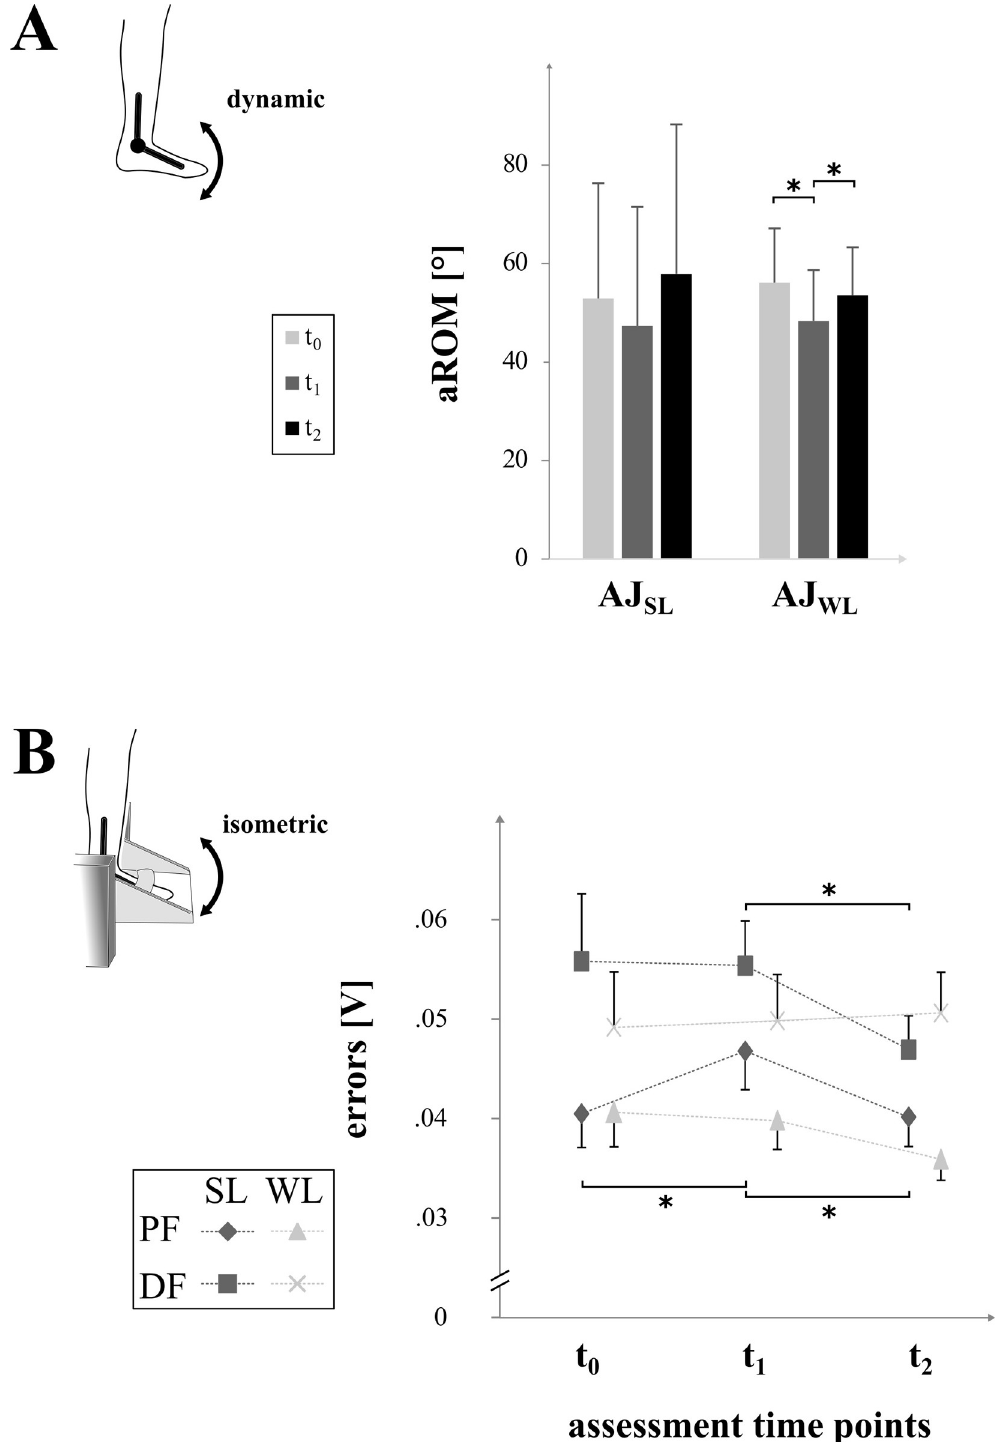
Fig 4. Angular mobility and motor accuracy. The graphs illustrate changes of mono-articular mobility (A) and motor accuracy (B) prior (t 0 ), after six weeks of no intervention (t 1 ) as well as after six weeks of WBV (t 2 ). “A” shows significant changes with an asterisk of active range of motion (aROM) in [˚] for the ankle joint of the stronger leg (AJ SL ) and weaker leg (AJ WL ). “B” illustrates errors (in [V]) during fine motor tasks for the plantar flexion (PF) and dorsal flexion (DF) with the stronger leg (SL, dark grey) and the weaker leg (WL, light grey).